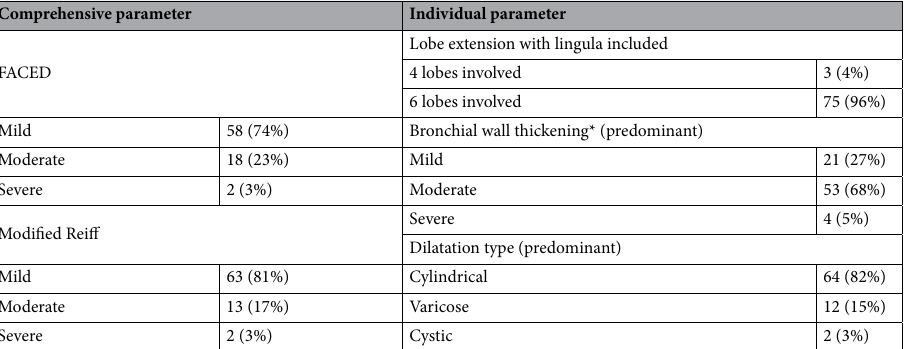
Table 3. Assessment of bronchiectasis by radiological and clinical parameters. Left part: systemic parameters. Right part: individual parameters. * Bronchial wall thickening by comparing with the adjacent artery